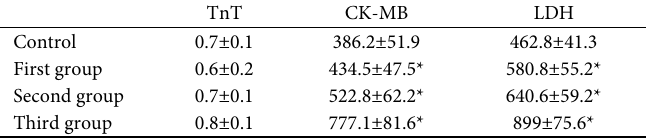
Table1. Serum TnT, CK‐MB and LDH in rats following carbon nanotubes treatment